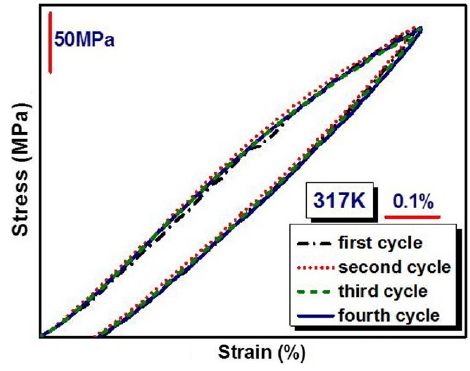
Figure 4. (a) Stress-strain curves at different temperatures in one cycle tensile test, (b) Temperature dependence of strain and recovery ratio, (c) Temperature dependent of deformation modulus and (d) Critical stress as a function of temperature of as-extracted Ni